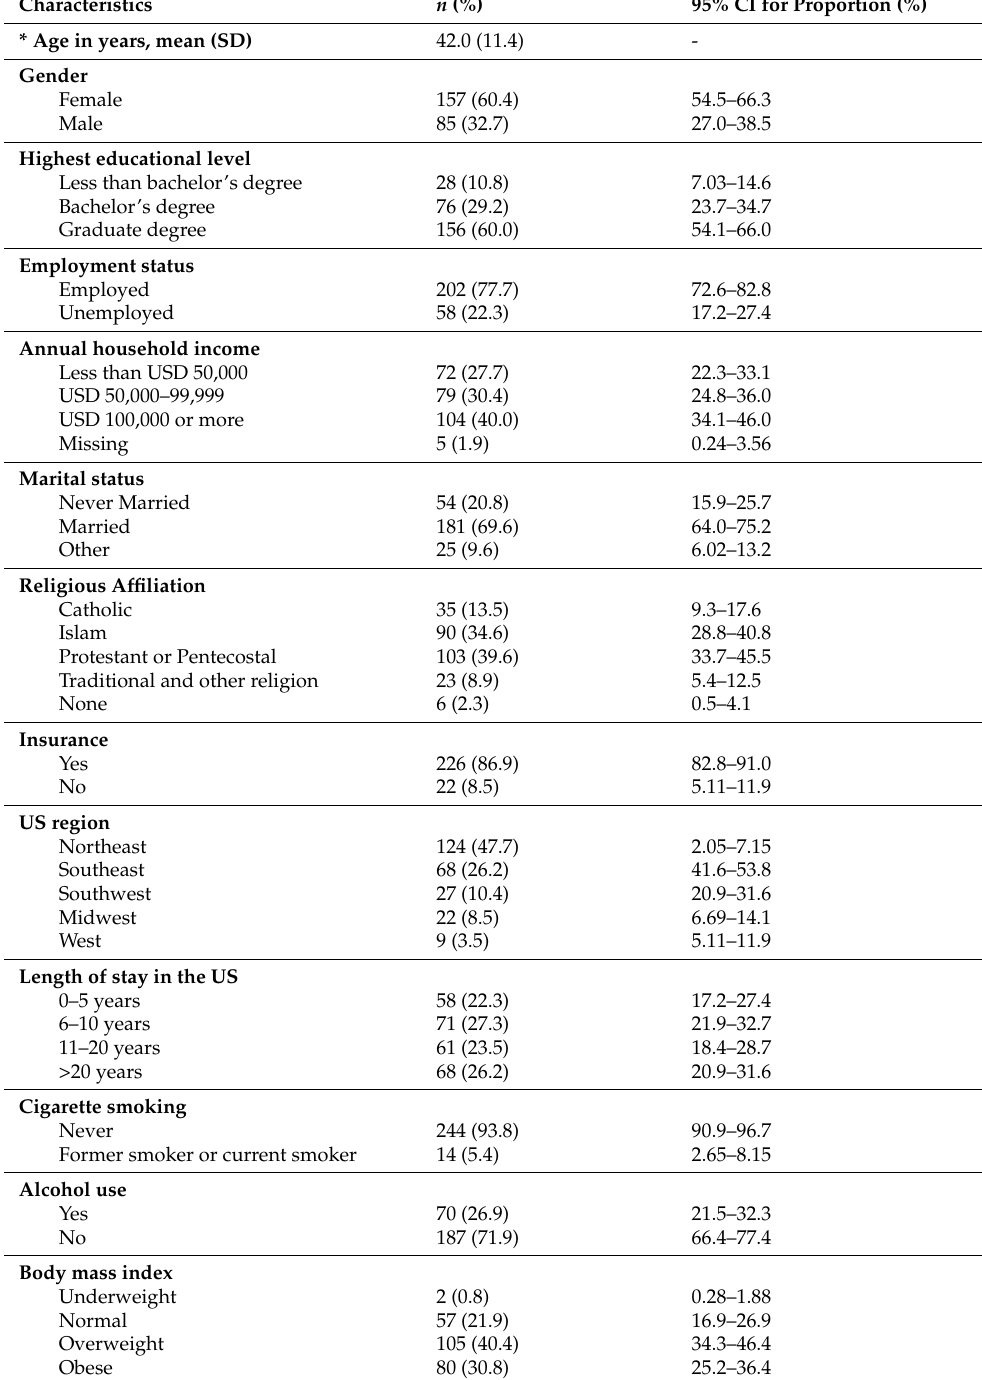
Table 1. Sociodemographic and health-related characteristics of the study participants, African Immigrant COVID-19 Study 2021 ( n =